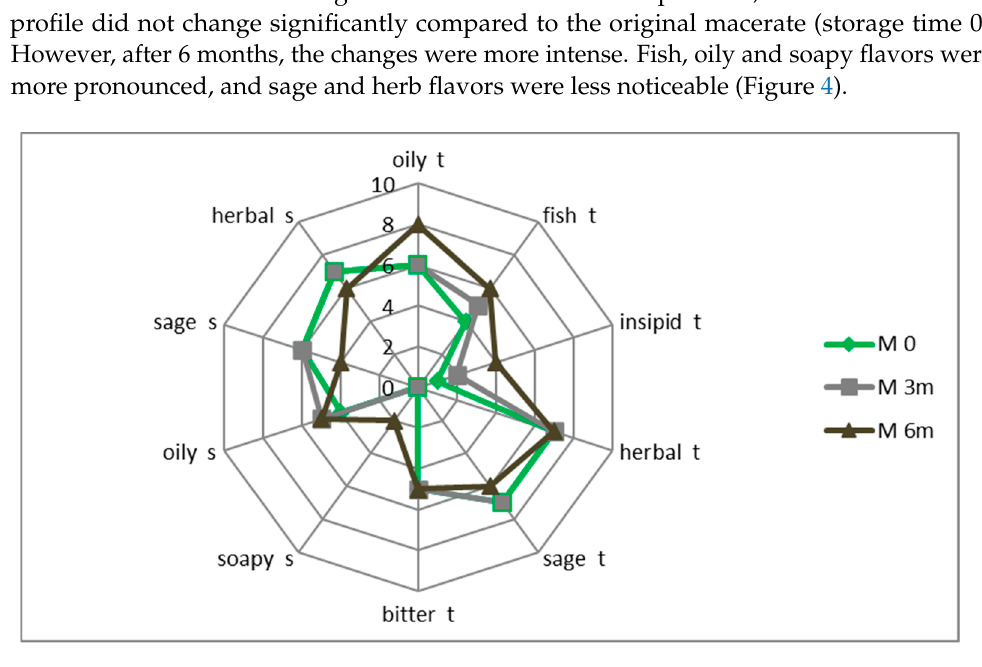
Figure 4. Macerate taste (t) and smell (s) profile after 3 (M 3 m) and 6 months (M 6 m) of refrigerated storage compared to the initial macerate (M 0).